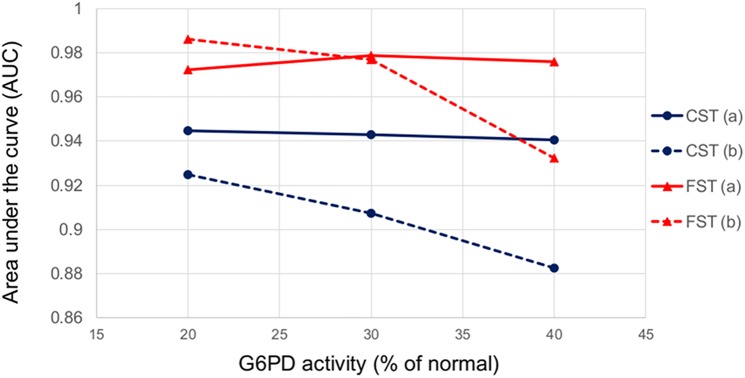
Area under the curve (AUC) vs threshold of G6PD activity (IU/gHb) in the two qualitative tests.FST results with (a) intermediates combined with deficient test results in red solid lines, (b) intermediates combined with normal test results in red dashed lines. CST results with (a) intermediates combined with deficient test results in blue solid lines, (b) intermediates combined with normal test results in blue dashed lines.